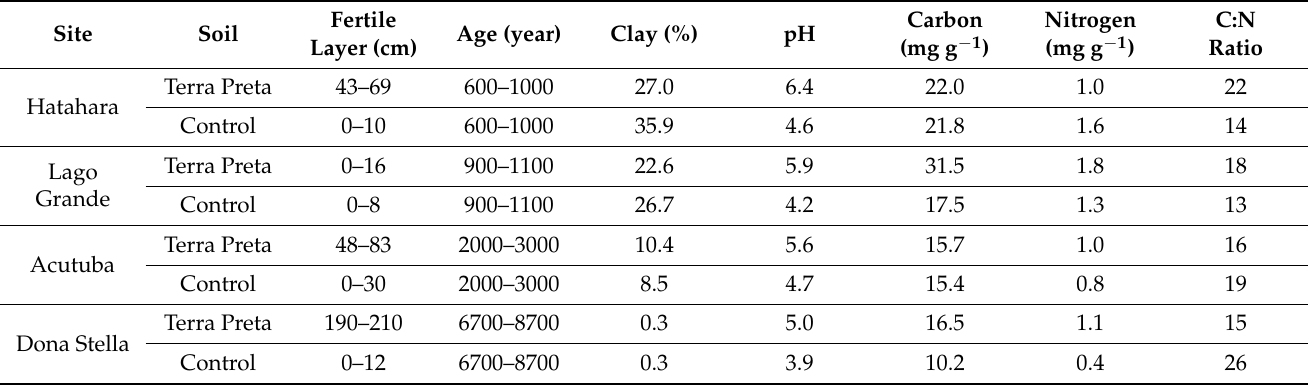
Table 1. Main physicochemical properties of the Columbian “Terra Preta” and similar non-biochar- affected control soils